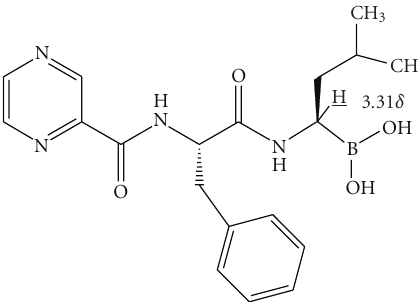
Figure 1: (R)-3-methyl-1-((S)-3-phenyl-2-(pyrazine-2- carboxamido)-propanamido)butylboronic acid.